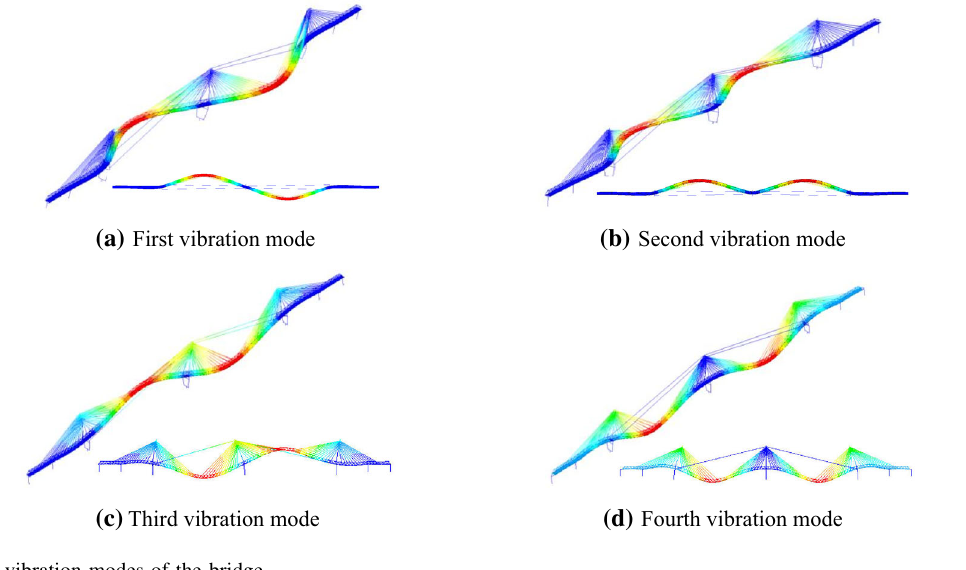
Fig. 7 First four vibration modes of the bridge Table 1 Information about the bridge vibration mode Mode no.